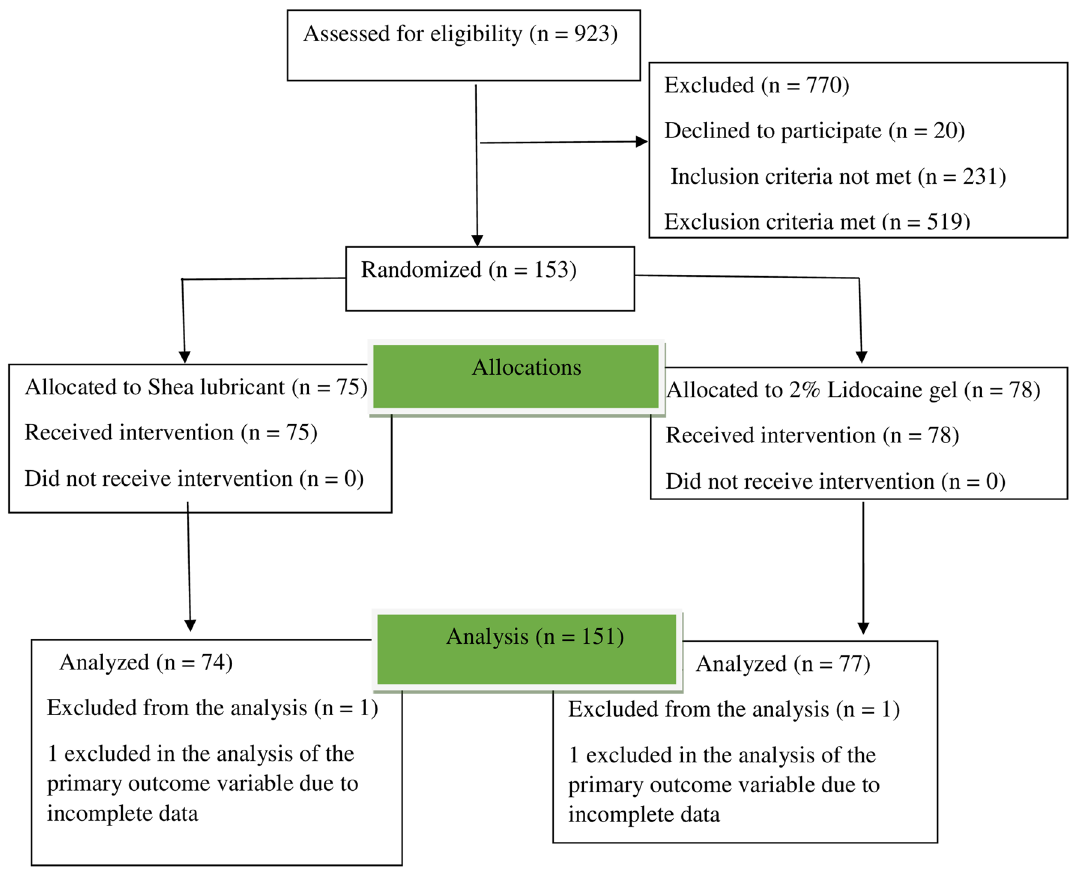
Figure 1. Summary of data collation and analysis.